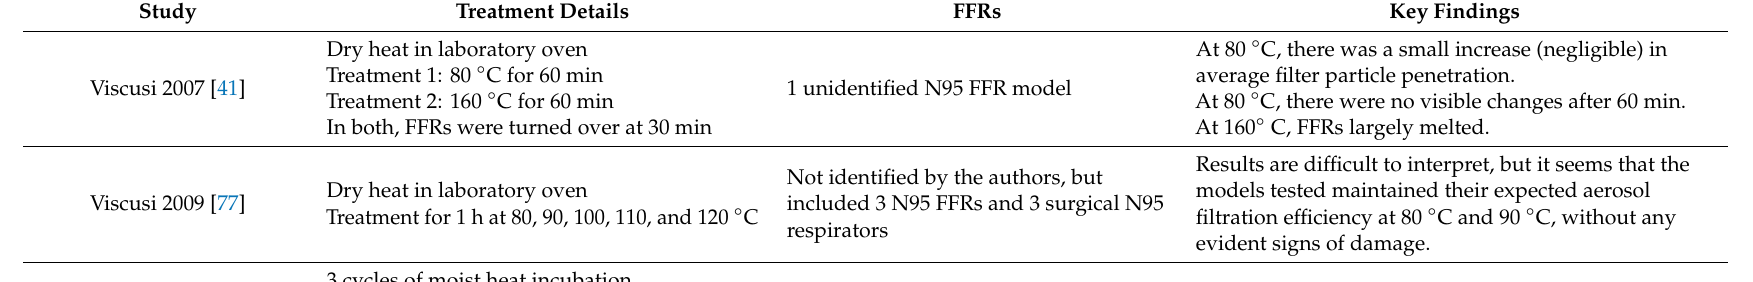
Table 7. Studies reporting on the e ff ects of heat treatment on filtering facepiece respirators